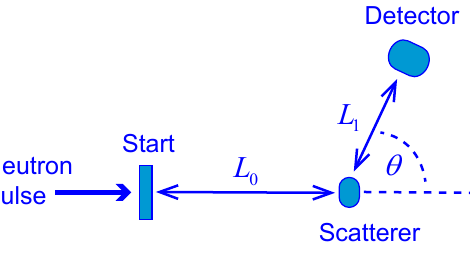
Figure 2. Schematic presentation of a time-of-flight neutron scattering setup. A detector, being a spatially localized system, performs a post-selection on the neutron’s final state. (Taken from [10], with permission from Quanta